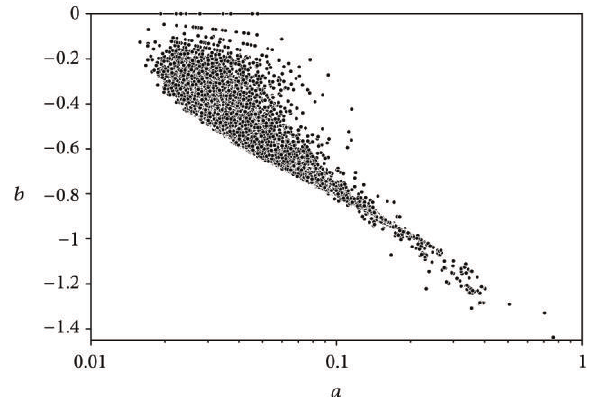
Figure 6: Locus (𝑎,𝑏) of PL regressions of all 2-tuple HSRFs in Dataset